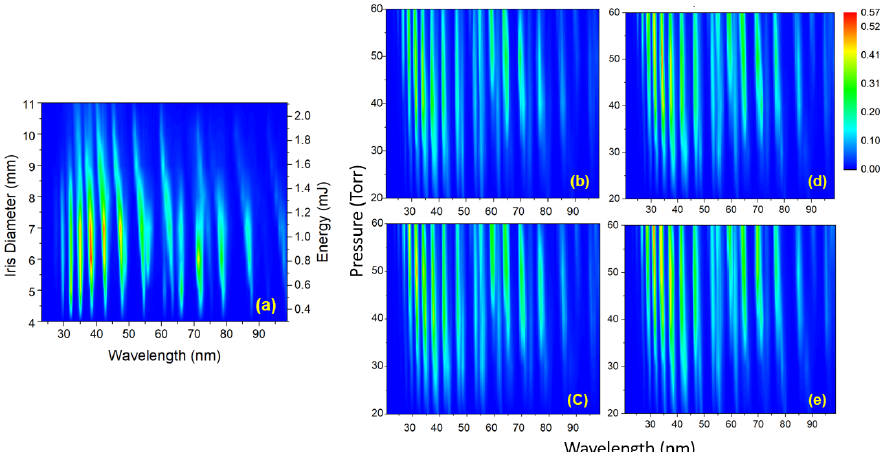
Figure 2. Laser beam diameter and laser focus position study. ( a ) HHG spectra obtained for various laser beam diameters and corresponding energies. ( b – e ) Indicative laser focus position study with respect to the exit pinhole of the semi-infinite gas cell: ( b ) − 1 mm, ( c ) 0 mm, ( d ) 1 mm, and ( e ) 2